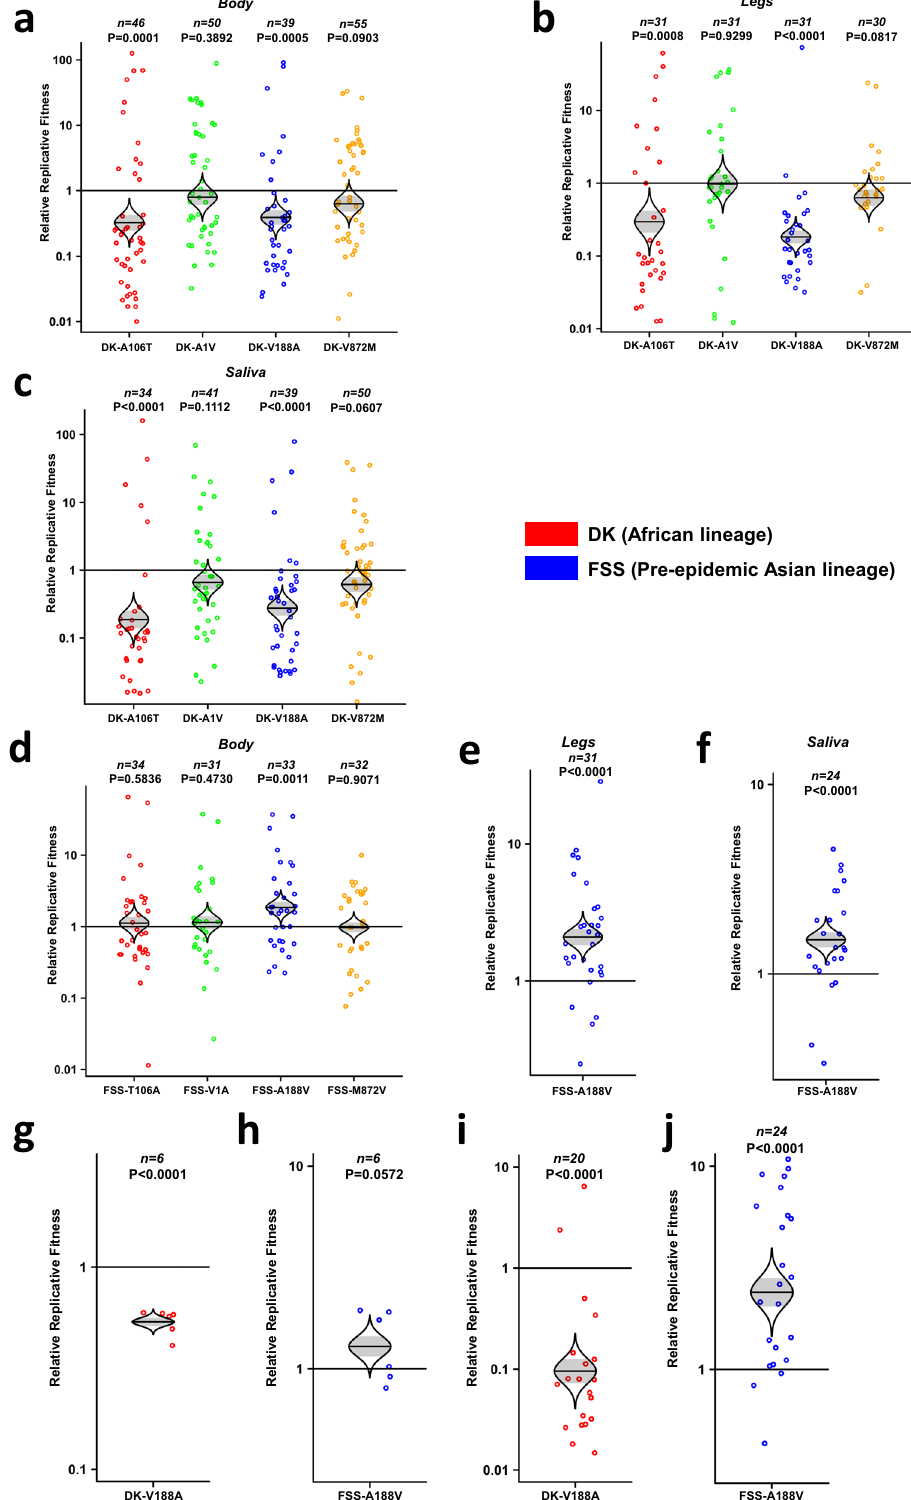
Fig. 3 The fi tness comparison of 4 individual mutant viruses against wild-type ZIKV strains in mosquitoes and A129 mice. a - c , The relative fi tness of individual mutants in the Dakar strain, tested in mosquito bodies ( a ), legs ( b ), and saliva ( c ). d – f The fi tness comparison of individual reversion mutants in the FSS13025 strain, tested in mosquito bodies ( d ), legs ( e ), and saliva ( f ). g , h Each point represents a single mosquito sample. The fi tness comparison of DK-V188A ( g ) and FSS-A188V ( h ) versus wild-type strains in mouse blood. i , j , The fi tness comparison of DK-V188A ( i ) and FSS-A188V ( j ) in mosquitoes after oral infection from viremic mice. a – j , The distribution of the model-adjusted means is illustrated by catseye plots with shaded±standard error (SE) overlaid by scatterplots of individual measures, which are shown on the log (base-10) scale such that comparisons are against a null value of 1. P values are calculated for the group (strain) coef fi cient for each linear regression model. n numbers represent biologically independent samples and shown on the top of each fi gure. Source data are provided as a Source Data fi le. a – f , i , j The results were pooled from 3 independent repeats. g , h The results were collected from a single